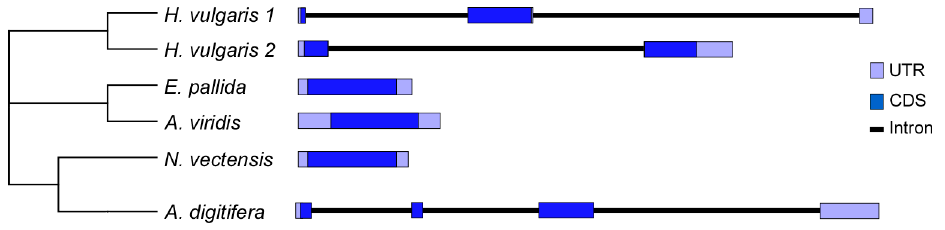
Figure 2. Gene structure for cnidarians TCTPs. The light boxes represent 5 ′ - and 3 ′ -UTR of the mRNA; while protein coding exons are shown in blue. Phylogeny of H. vulgaris , E. pallida , A. viridis , N. vectensis and A. digitifera based on data herein reported. CDS, coding DNA sequence.